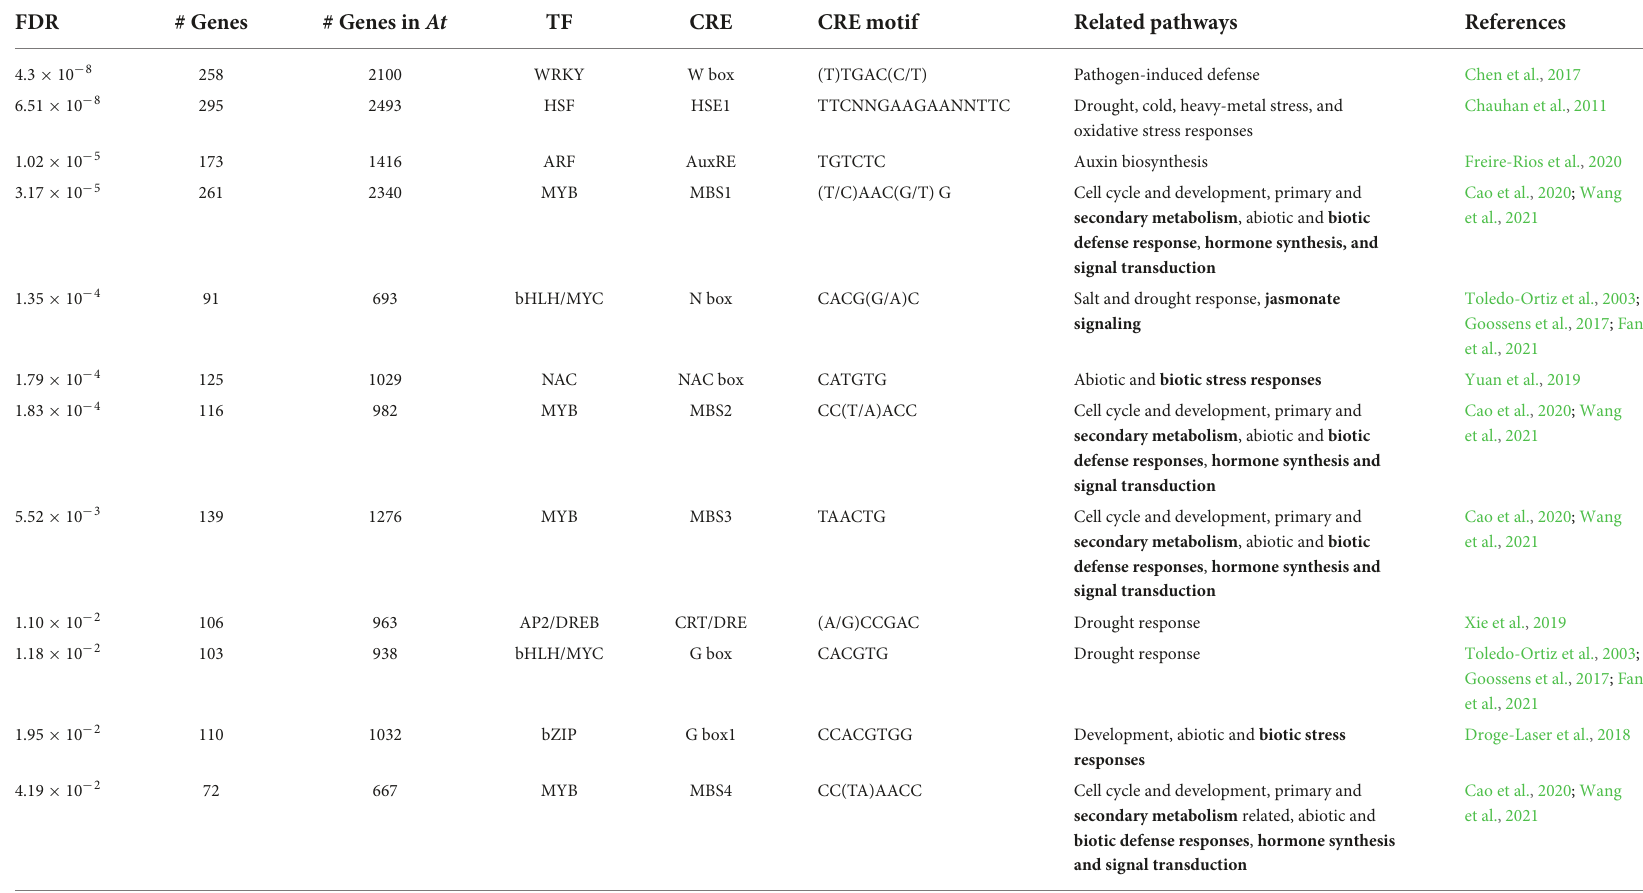
TABLE 6 List of enriched stress responsive transcription factors (TF), their obtained FDR values and the number of genes found for each TF group among those found in A. thaliana (At). FDR #